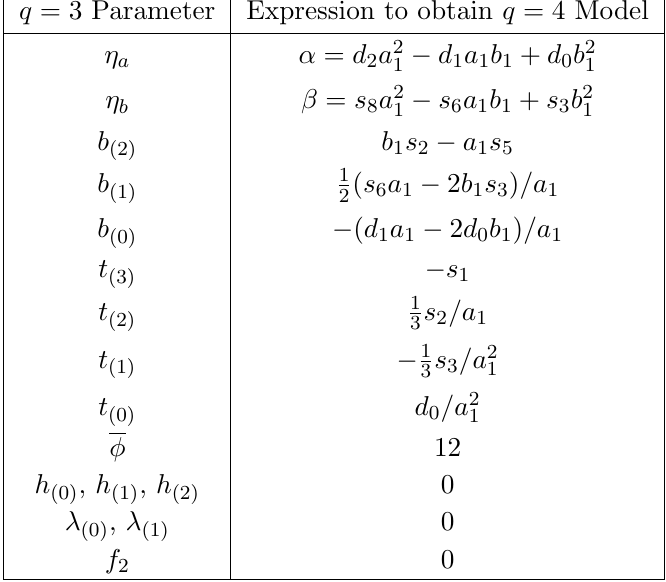
Table 5 . Replacements for converting the q = 3 model to the q = 4 model. Note that divisions by a 1 are required for the conversions.